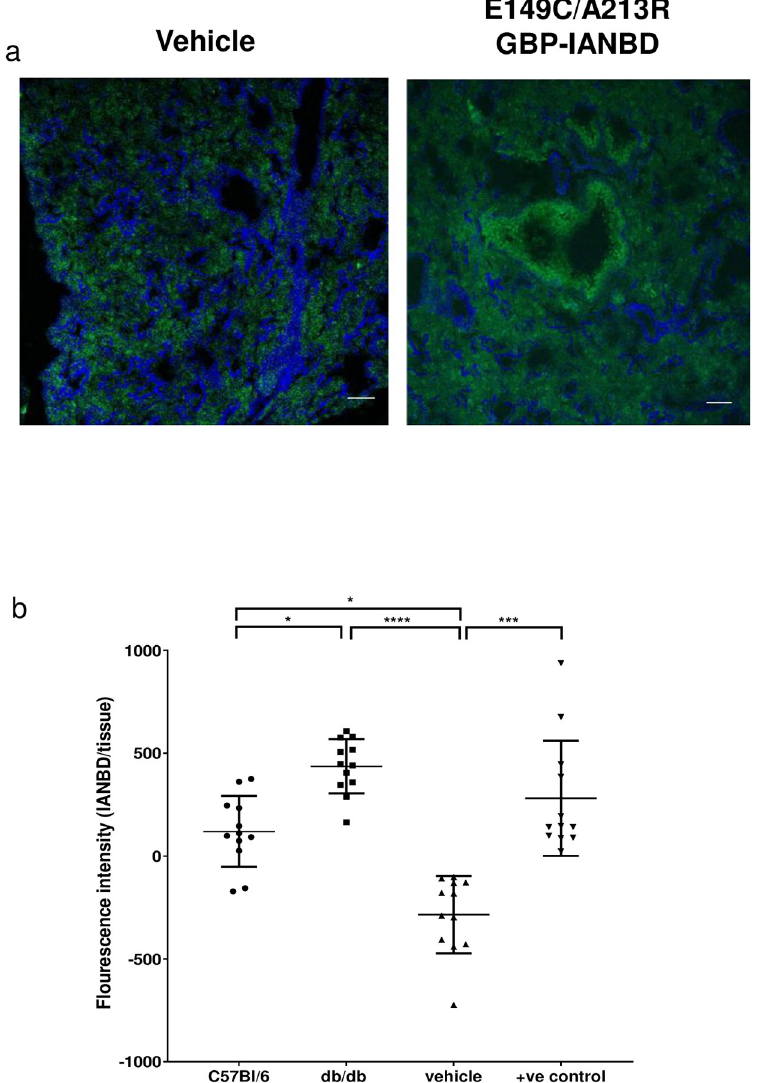
Fig 8. Exemplar images showing spectral un-mixing of cryo-sectioned C57Bl/6 (wild type) lungs treated with a. vehicle and b. E149C/A213R GBP-IANBD. Artificially coloured IANBD emission spectra collected from the sample (green), and artificially coloured lung tissue spectra (blue). Scale bar is 20 μ m. Fluorescence intensity of E149C/A213R GBP-IANBD spectra surrounding the luminal regions were measured with ImageJ. c. collated data of fluorescence intensity of cryo-sections from C57Bl/6 or db/db mice treated with E149C/A213R GBP-IANBD, or C57Bl/6 treated with vehicle, or C57Bl/6 treated with E149C/A213R GBP-IANBD pre-bound with 10 mM D-glucose (+ve control). Data are shown as mean ± SD. Significantly different � p < 0.05, ��� p < 0.001, ���� p < 0.0001.